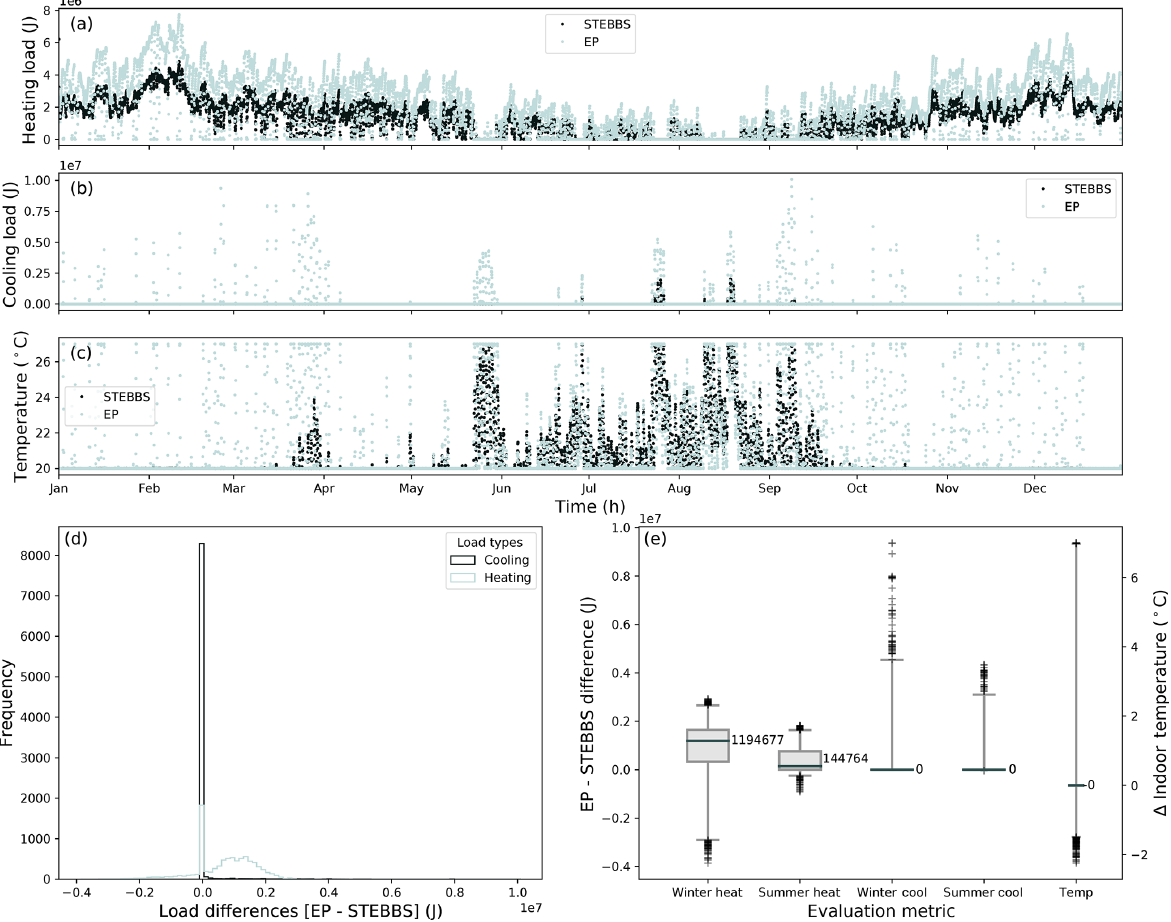
Figure B2. BESTEST Case 600 is used with London weather data to evaluate STEBBS relative to EnergyPlus (EP) at an hourly timescale for 2012 (a) heating and (b) cooling loads ( J ), (c) indoor air temperature, (d) frequency distribution of hourly differences between EnergyPlus and STEBBS for heating and cooling loads, (e) interquartile range of hourly differences in winter (January, February, March, October, November, December) and summer (May, June, July, August) loads, and indoor temperatures (whiskers 1% and